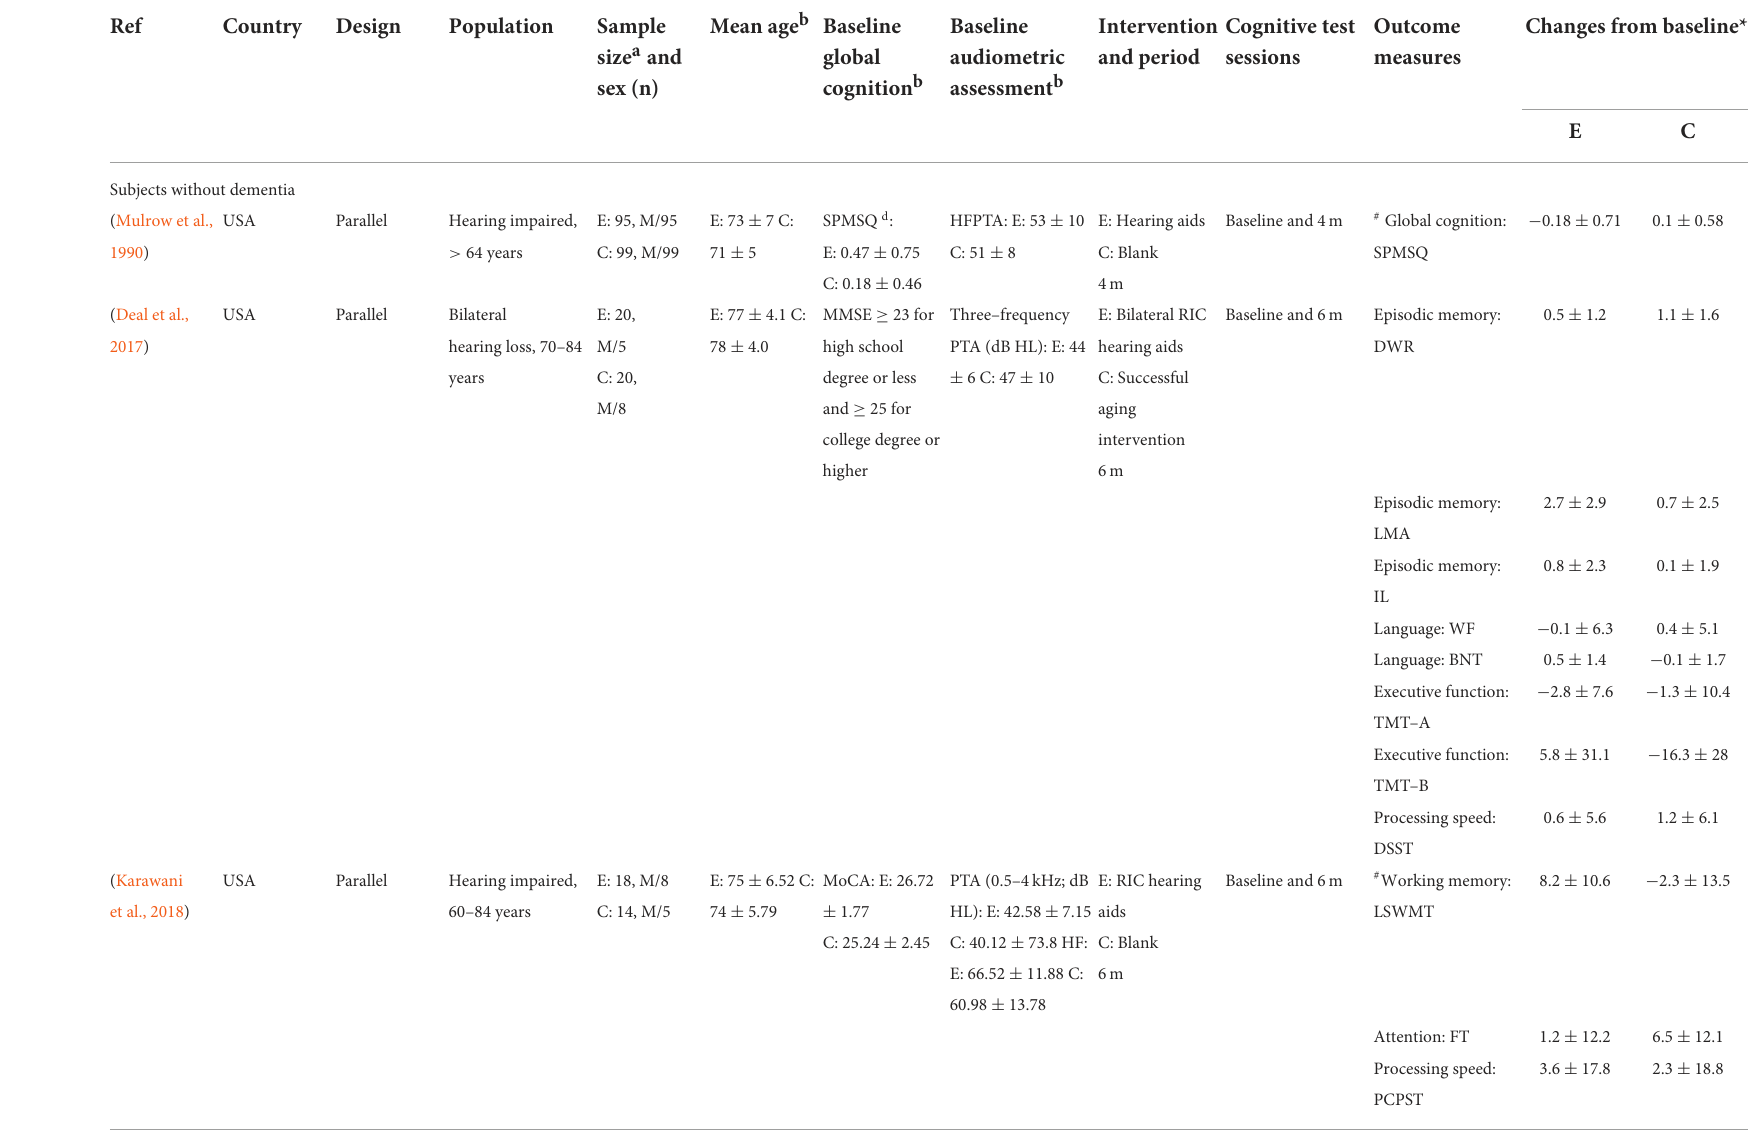
TABLE 1 Characteristics of